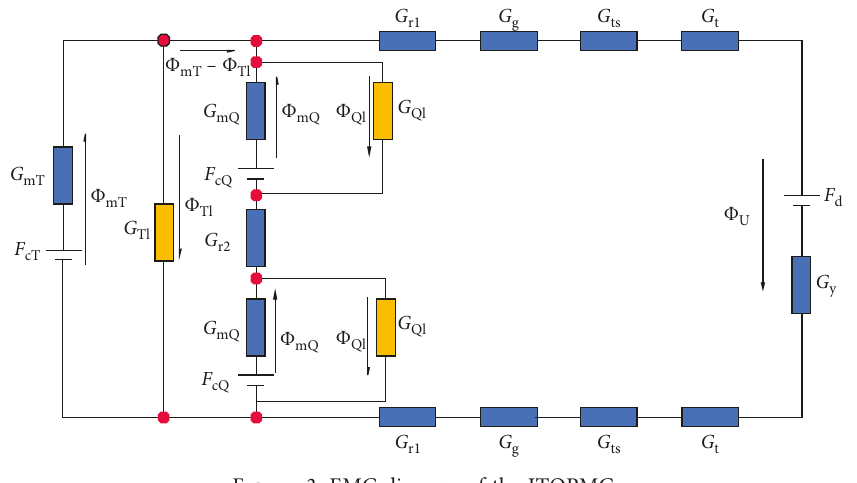
Figure 3: EMC diagram of the ITQPMG.